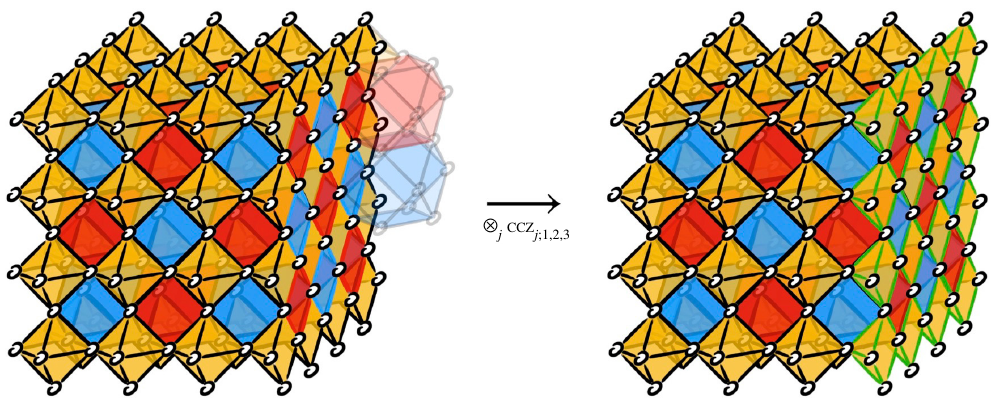
FIG. 35. An illustration of an ( m 1 , m 2 , m 3 ) -boundary in a stack of three copies of 3D toric codes. The boundary is on the right of the lattice, where the support of the stabilizers is reduced. The code the X stabilizers of which are given by the yellow octahedra have the support of their stabilizers reduced to be weight-5, while the red and blue stabilizers, of codes 2 and 3, have weight-4 face stabilizers on the boundary. For illustrative purposes, we show to the right how the stabilizers would normally have larger support—these qubits are faded out. On the right side, after the application of ⊗ j CCZ j ;1,2,3 , the bulk X stabilizers are preserved while those the supports of which were cut at the boundary of the hole are now transformed to be of the form explained in Fig.